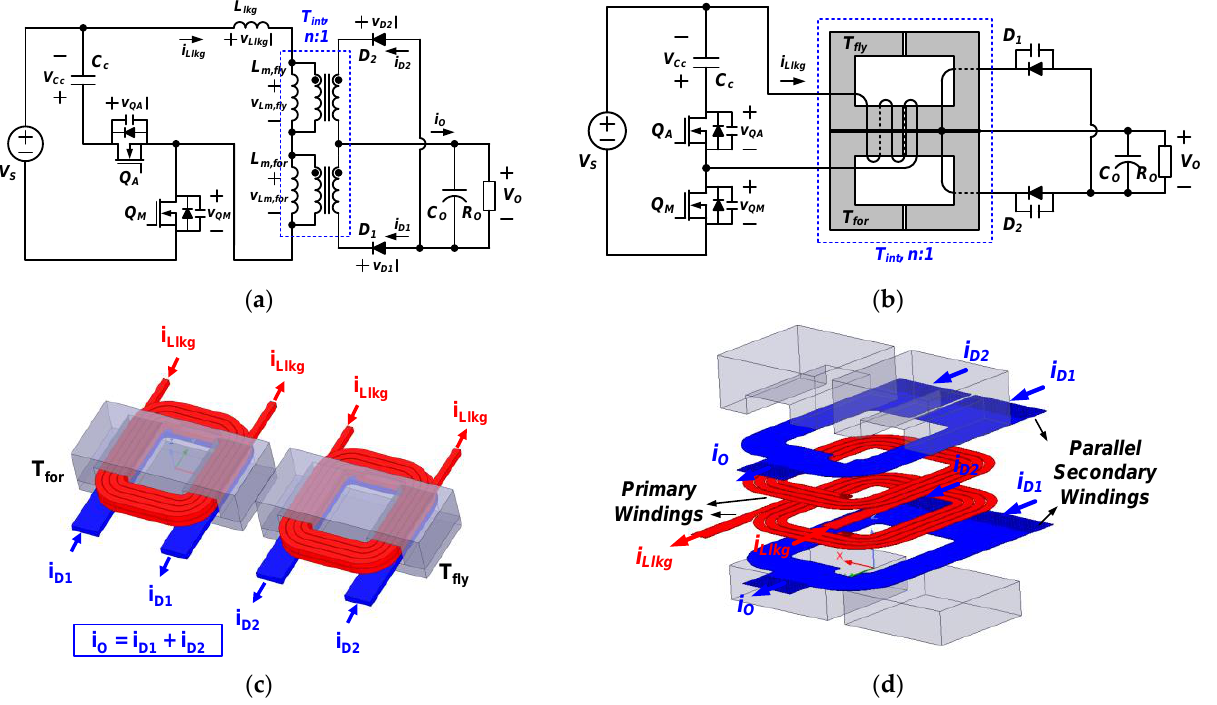
Figure 4. Proposed ACFF converter with integrated planar transformer: ( a ) Circuit diagram. ( b ) Cir- cuit diagram with integrated transformer. ( c ) Structure of two conventional transformers with wire and busbar. ( d ) Structure of integrated planar transformer with PCB windings.